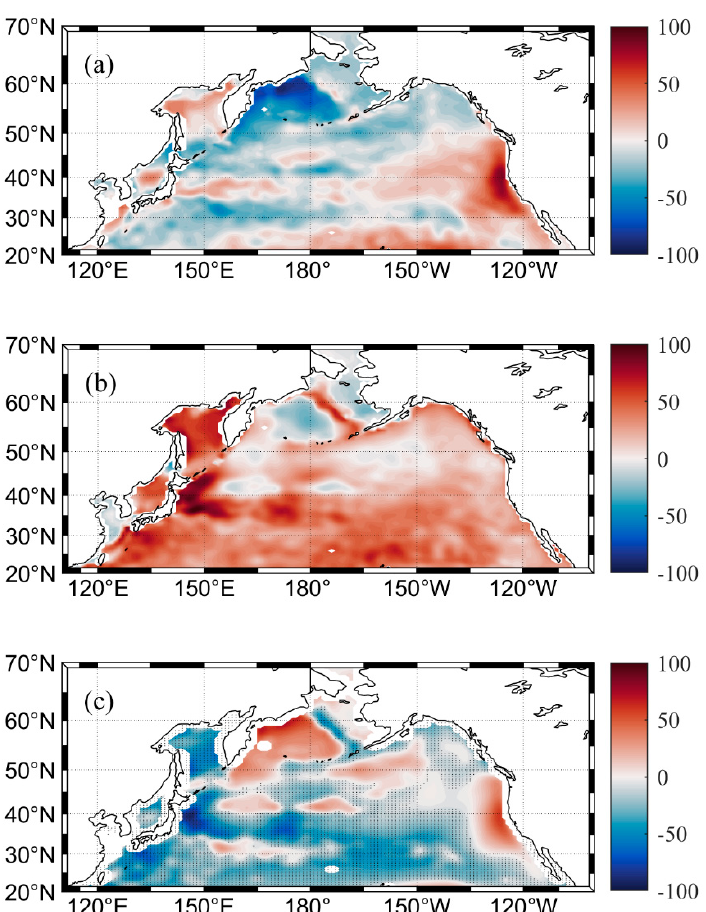
Figure 9. Spatial patterns of mixed layer depth biases in north Pacific (units: °C) in winter (DJF) between the predictions and observation: ( a ) modified FIO − ESM − CPS results, ( b ) original FIO − ESM − CPS results, and ( c ) the difference of absolute average error between modified and original FIO − ESM − CPS at 1-year lead time. Stipples denote the improvement of absolute average error between modified and original FIO − ESM − CPS over 20%.